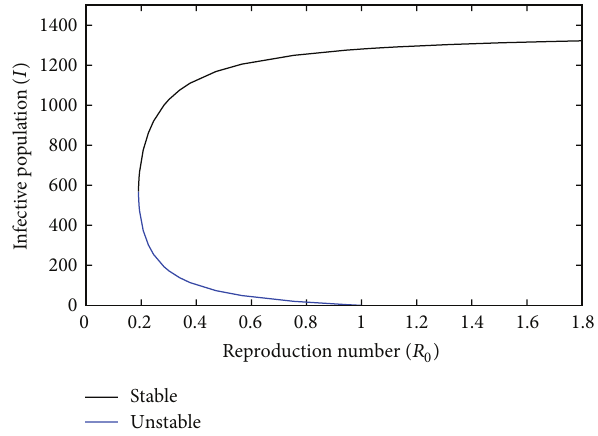
Figure 6: Backward bifurcation diagram for 𝛿 > 1 for the parameter values 𝑏 1 = 240 , 𝜆 1 = 0.00012 , 𝛼 = 0.08 , 𝜇 1 = 0.16 , 𝛾 = 0.015 , 𝜆 2 = = 550 , 𝜇 = 0.5 0.0001 , 𝑏 2 2